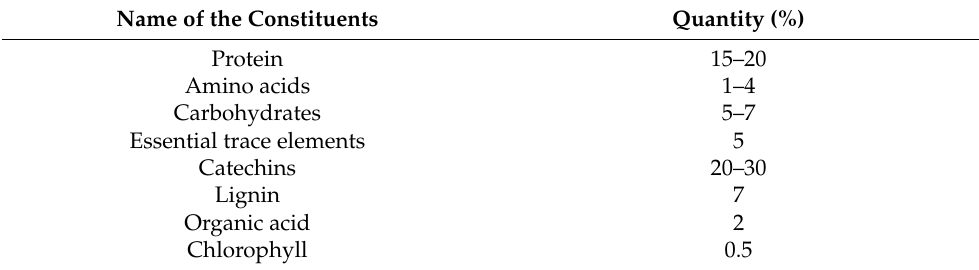
Table 1. Major beneficial constituents of green tea [9,10].